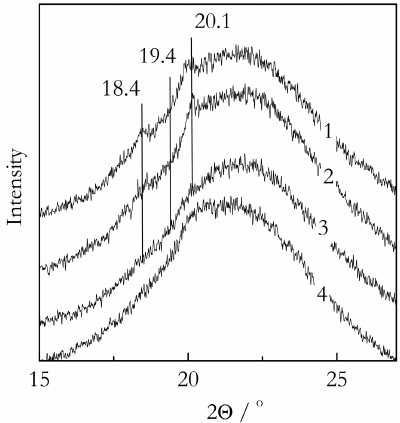
Figure 2. X-ray difractograms of the PVDF nanoconfined gels in 30 nm silica pores: PVDF/TG/NAT (1), PVDF/TG/OM (2) PVDF/BL/NAT (3), and PVDF/BL/OM (4).